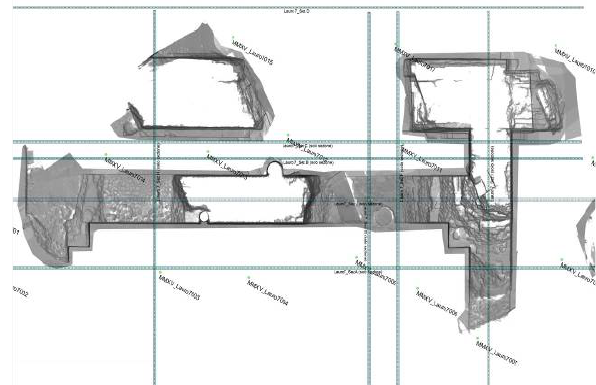
Figure 8. Vertical section plans of the via del Lauro 7 point cloud.